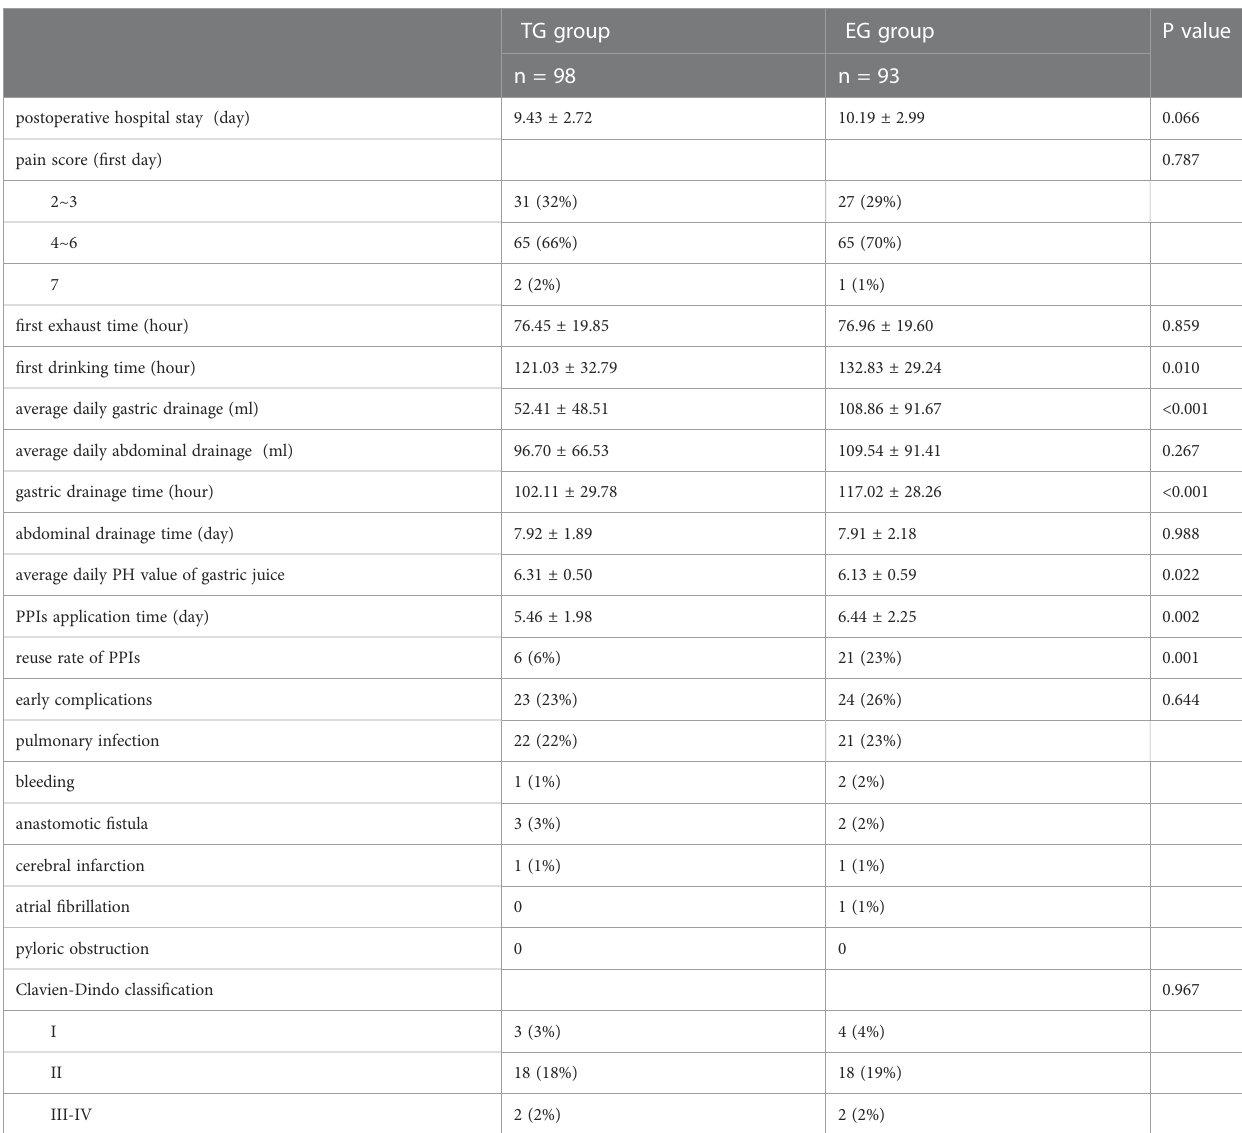
TABLE 3 Postoperative